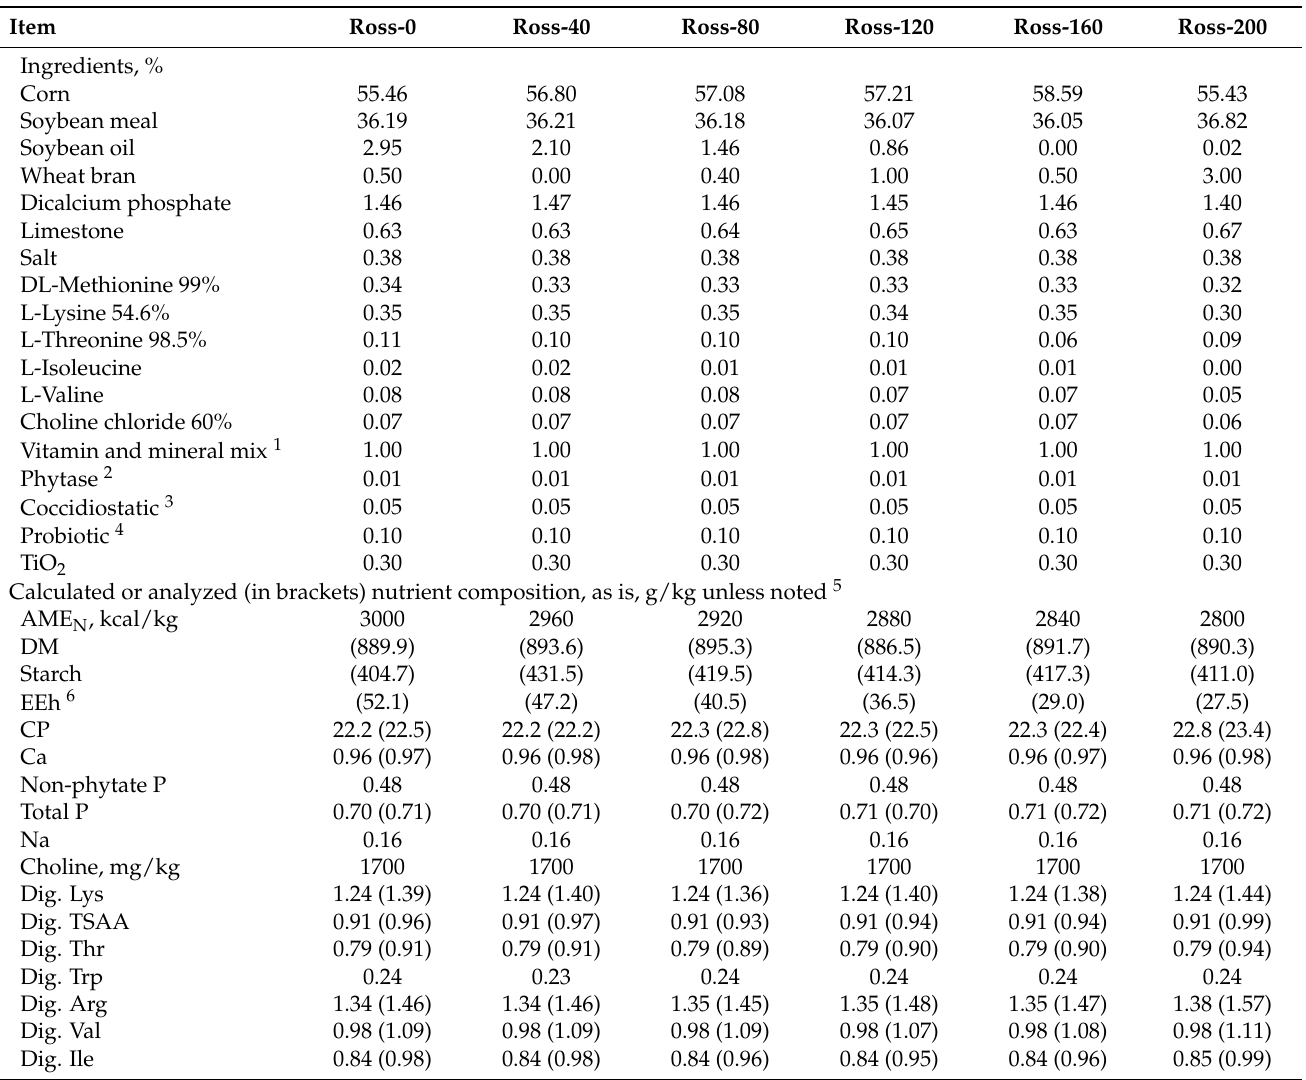
Table 1. Ingredient and nutrient composition of the experimental diets used as starter, as